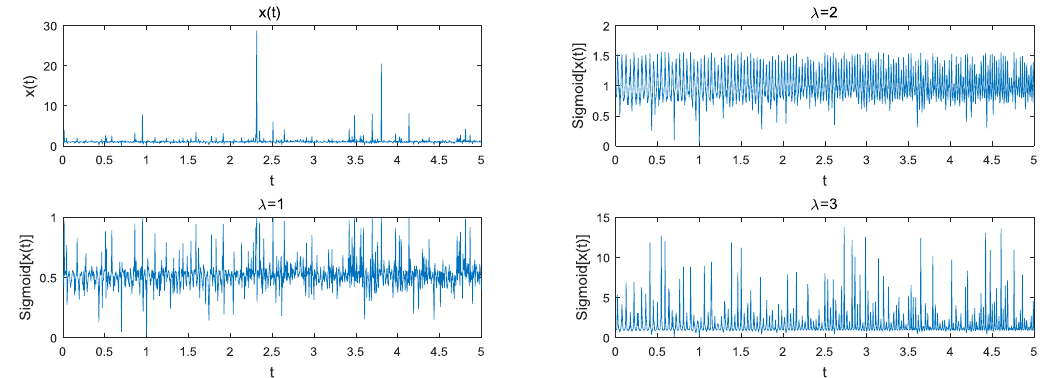
Figure 4. S α S noise suppression with GSNR = 5dB and α = 1.2 versus the inclined coefficient λ Figure 4. S S  noise suppression with GSNR 5dB  and 1.2  versus the inclined coefficient  .